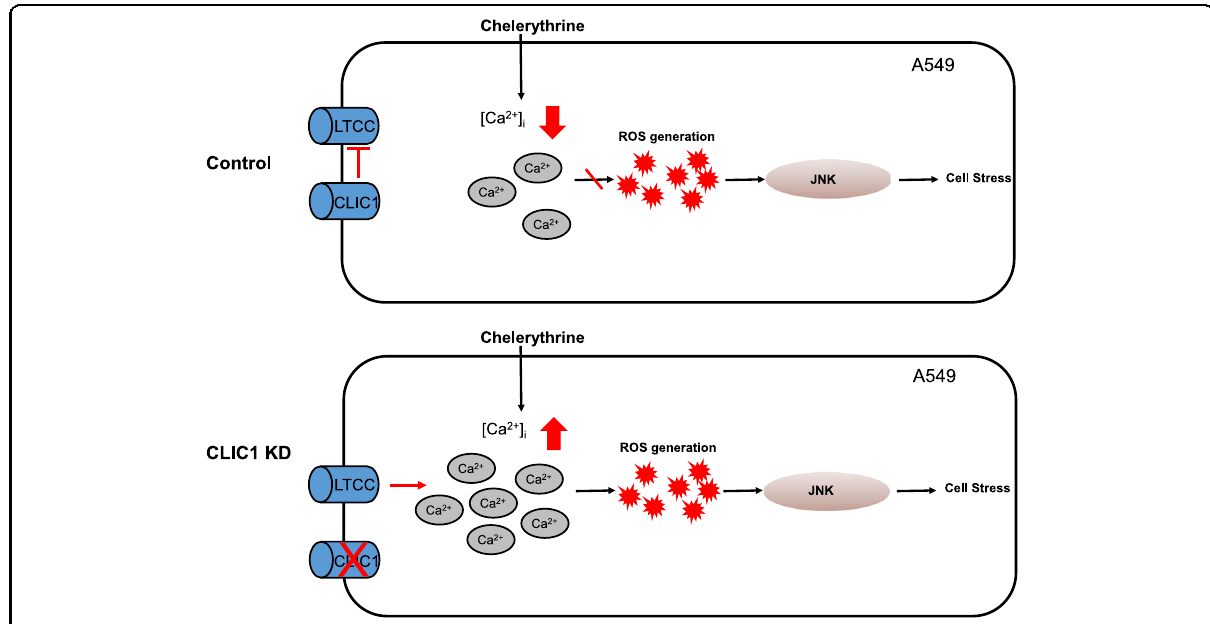
Fig. 7 A working hypothesis. In A549 control cells, CLIC1 blocked the L-type calcium channel and diminished the effects of chelerythrine on [Ca 2 + ] i . When CLIC1 was depleted, the intracellular calcium level was increased through the LTCC and increased calcium-enhanced ROS generation. ROS accumulation might lead to JNK phosphorylation, resulting in an increase in cellular